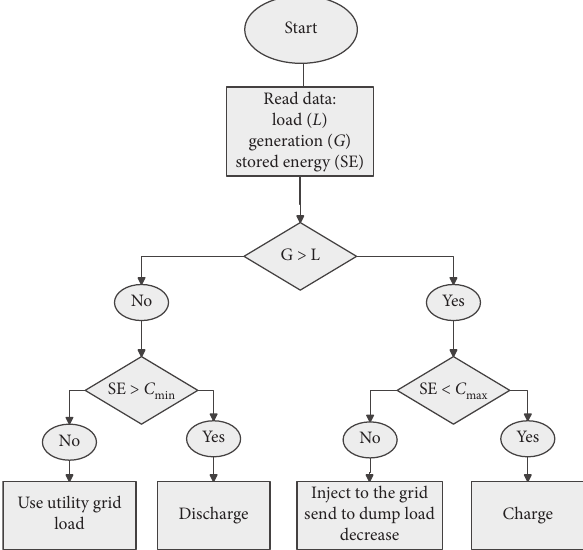
Figure 7: Example of myopic